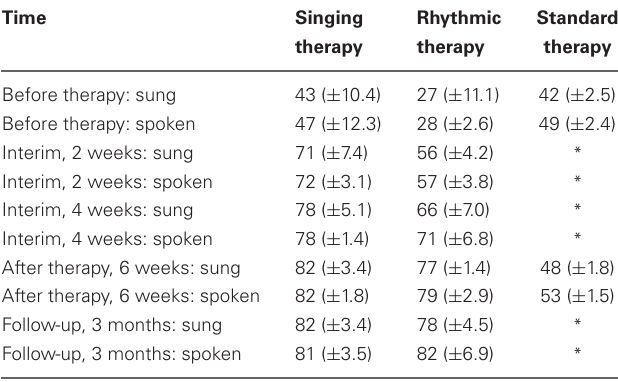
Table 4 | Formulaic lyrics.